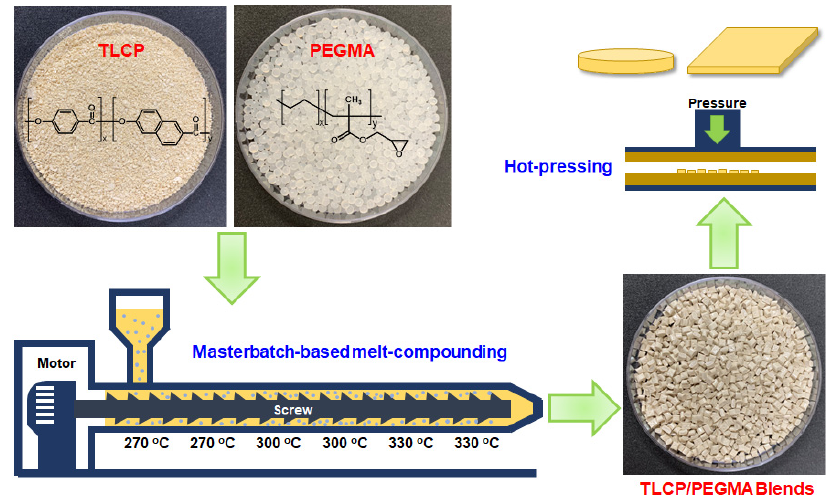
Figure 1. A schematic procedure for fabricating thermotropic liquid crystalline polyester (TLCP)/poly(ethylene- g -glycidyl methacrylate) (PEGMA) blends via masterbatch-based melt- compounding.